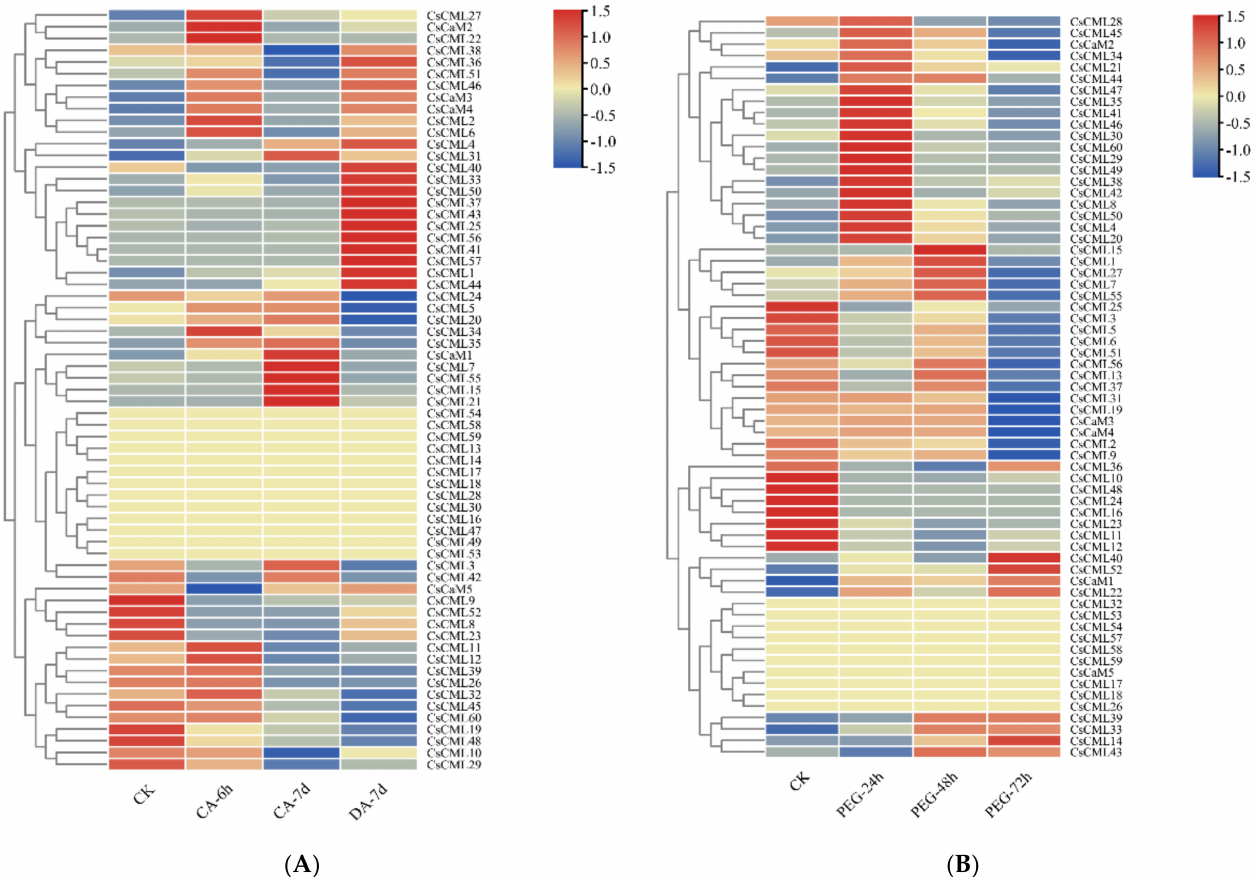
Figure 8. Expression profiles of CsCaM and CsCML genes under cold and drought stress. ( A ) The cold stress expression pattern of the tea plant was not adapted to 25~20 ◦ C (CK), fully adapted to 10 ◦ C for 6 h (CA − 6 h) and 10~4 ◦ C for 7 days (CA − 7d), and recovered for 7 days (DA − 7d) at 25~20 ◦ C. ( B ) Expression patterns of tea plants treated with 25% polyethylene glycol (PEG) for 0 h, 24 h, 48 h, and 72 h under drought